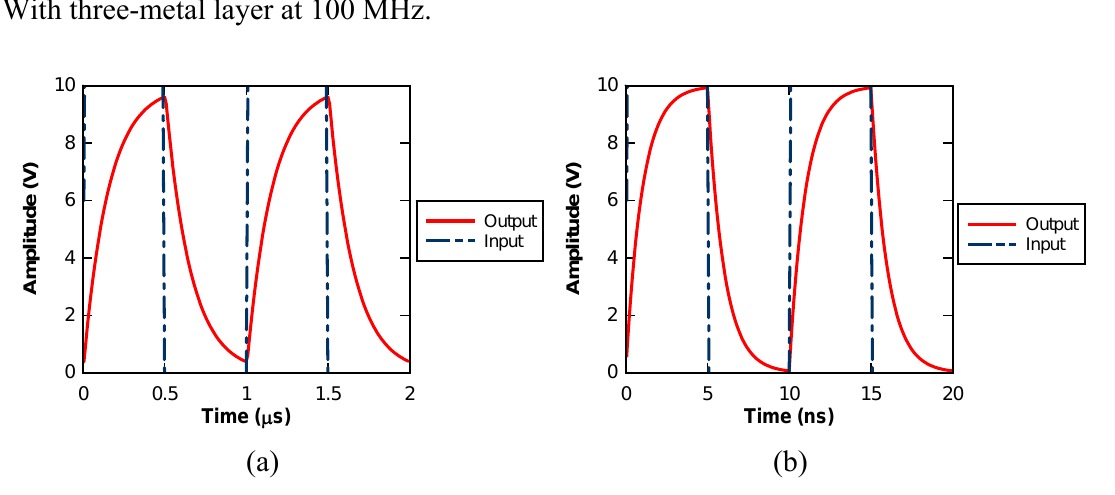
electrode: (a) With two-metal layer at 1 MHz (b) 1